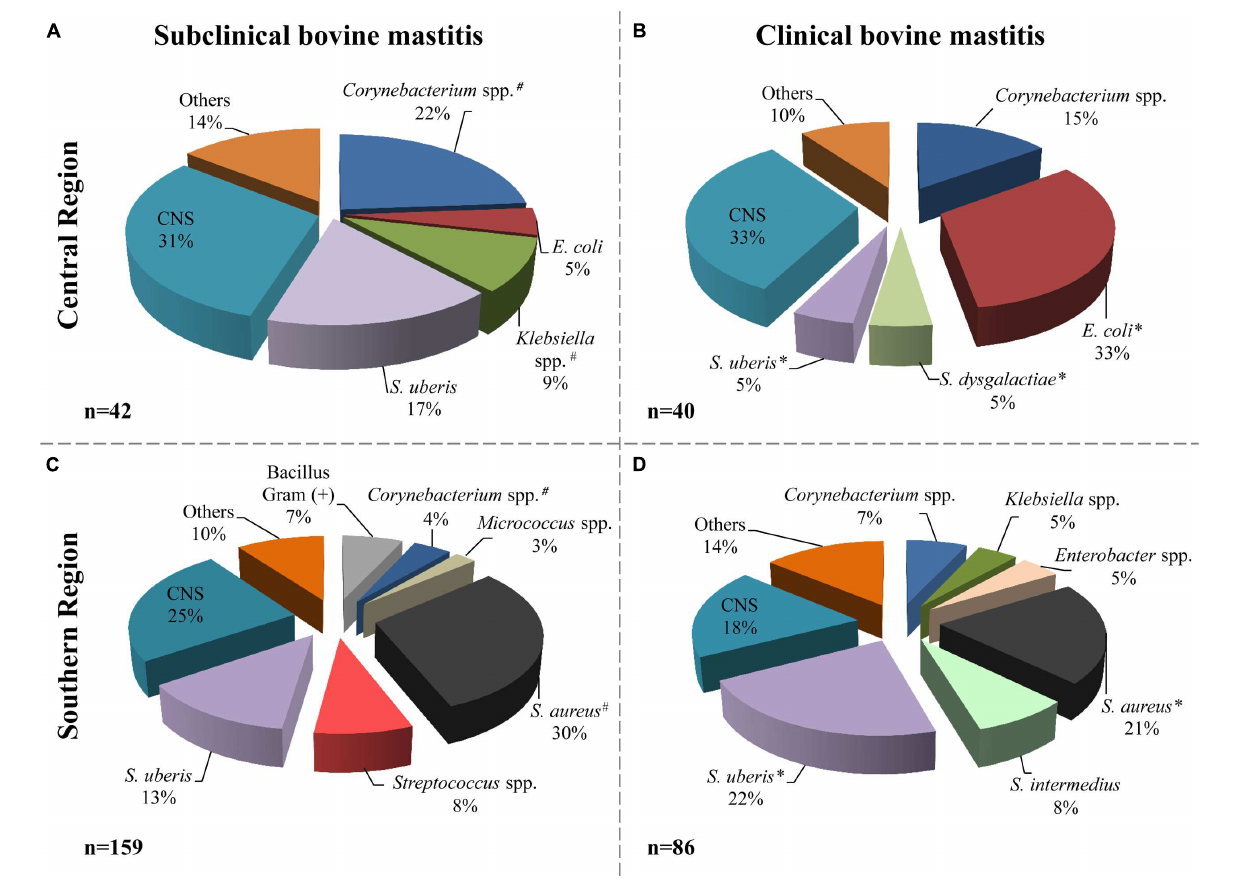
FIGURE 2 | Bacterial species distribution isolated from milk samples. Microorganisms identified in subclinical ( A , central; C , southern) and clinical ( B , central; D , southern) mastitis milk samples. The central region includes 82 isolates and the southern region includes 245 isolates. The label “Others” includes microorganisms isolated with frequency ≤ 2% of the total. # indicate that the frequency of isolation of microorganisms, from subclinical mastitis, between the regions is significantly different ( p ≤ 0.05). ∗ indicate that the frequency of isolation of microorganisms, from clinical mastitis, between the regions is significantly different ( p ≤ 0.05). Others included: Enterobacter cloacae , Enterococcus faecium , Streptococcus spp., Bacillus , non-fermenting Bacillus , Aeromona , Yersinia sp., Serratia sp., and Candida spp. TABLE 1 | Percentage of antibiotic resistance for the most frequently identified isolates from clinical bovine mastitis milk samples. Central region South